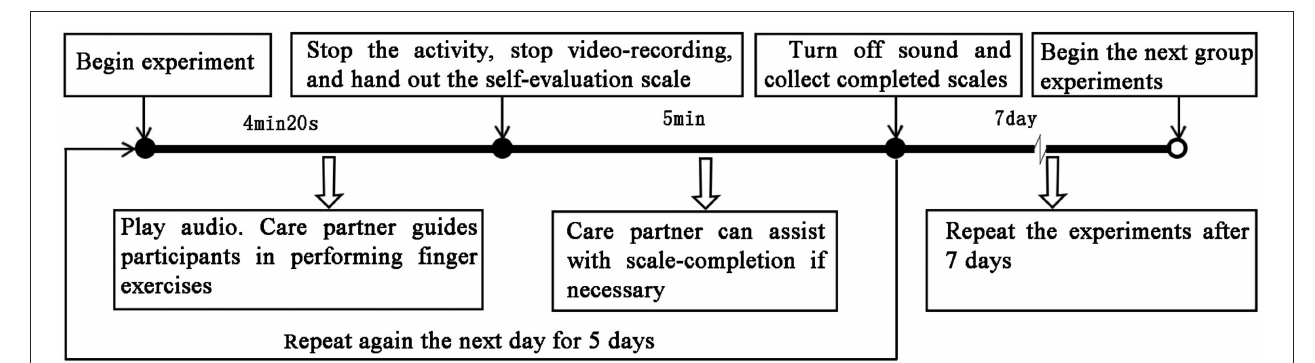
FIGURE 4 | Experimental procedure